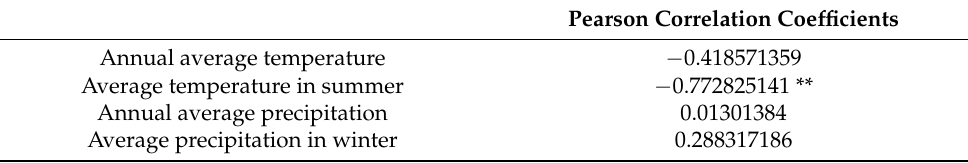
Table 3. Pearson correlation